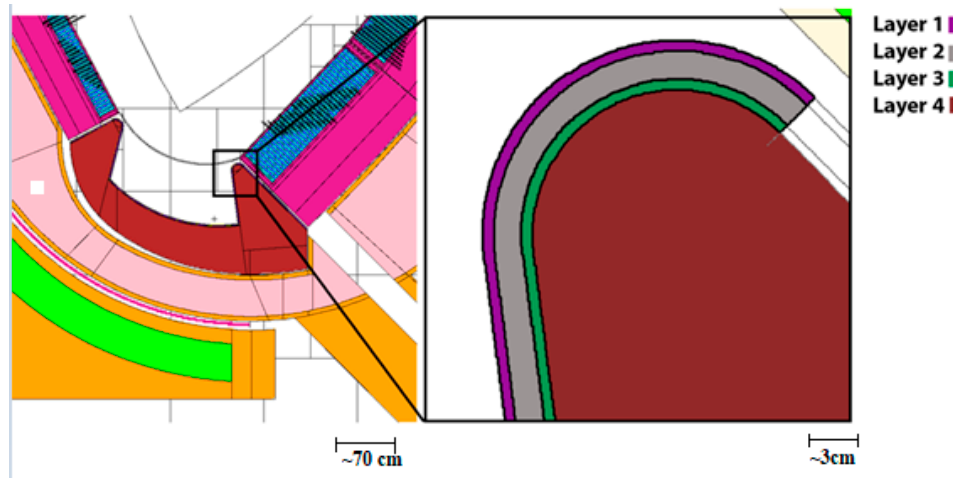
Figure 10. MCNP model of the divertor cassette [43].